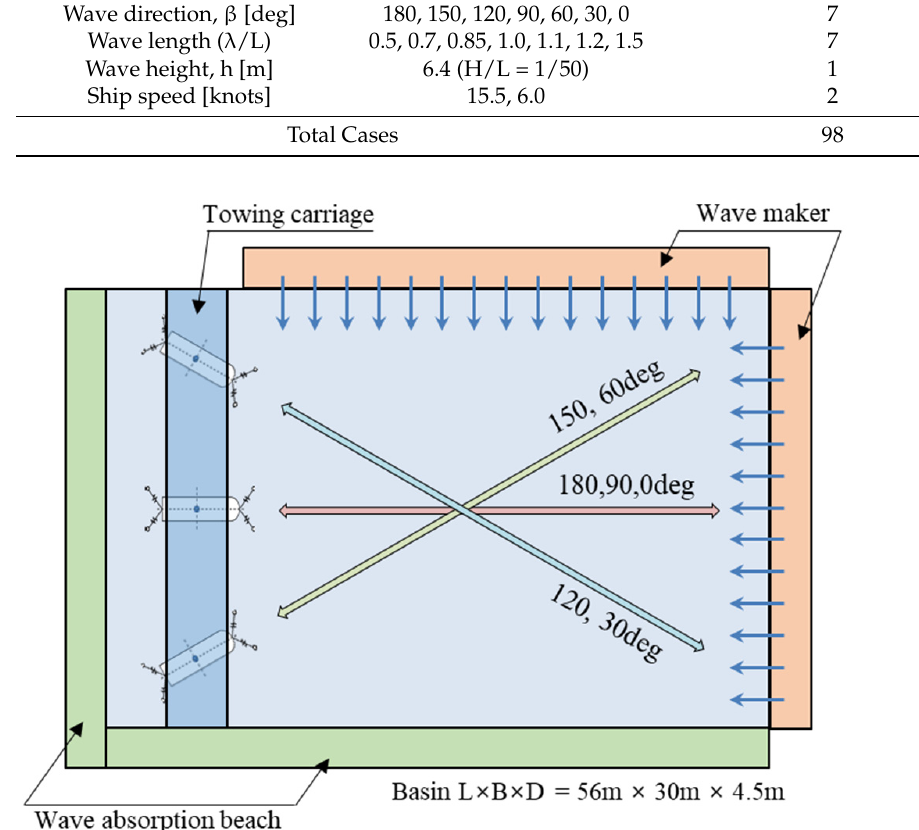
Figure 2. Ocean engineering basin in KRISO.